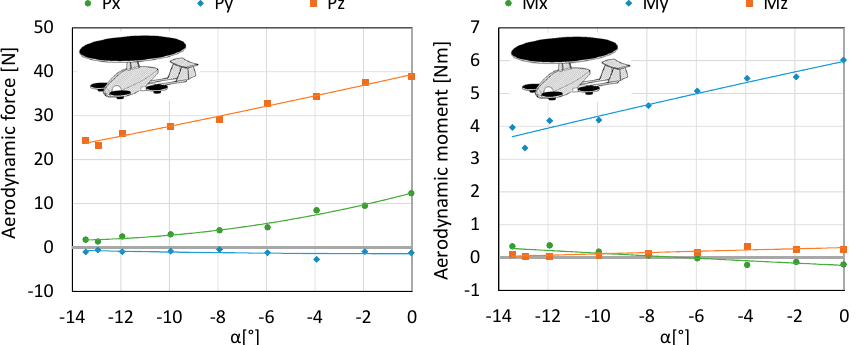
Figure 5. Characteristics of coefficients of forces and aerodynamic moment for configuration K1.